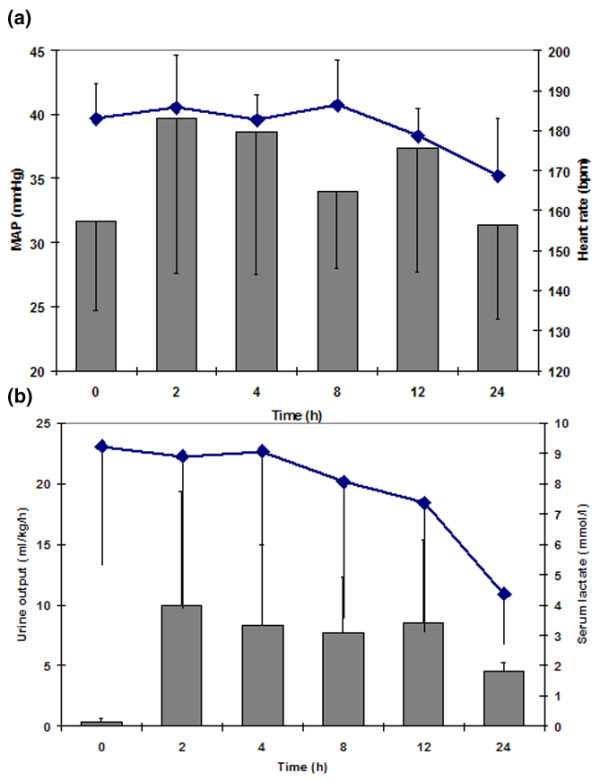
Cardiovascular parameters and urine output and serum lactate in ELBW infants with sepsis before and after initiation of arginine-vasopressin therapy. (a) Cardiovascular parameters: columns show mean arterial blood pressure (MAP; mmHg); lines show heart rate (beats per minute). Values given as mean ± standard deviation. (b) Urine output and serum lactate: columns show urine output (ml/kg body weight/h); lines show serum lactate (mmol/l). Values given as mean ± standard deviation.